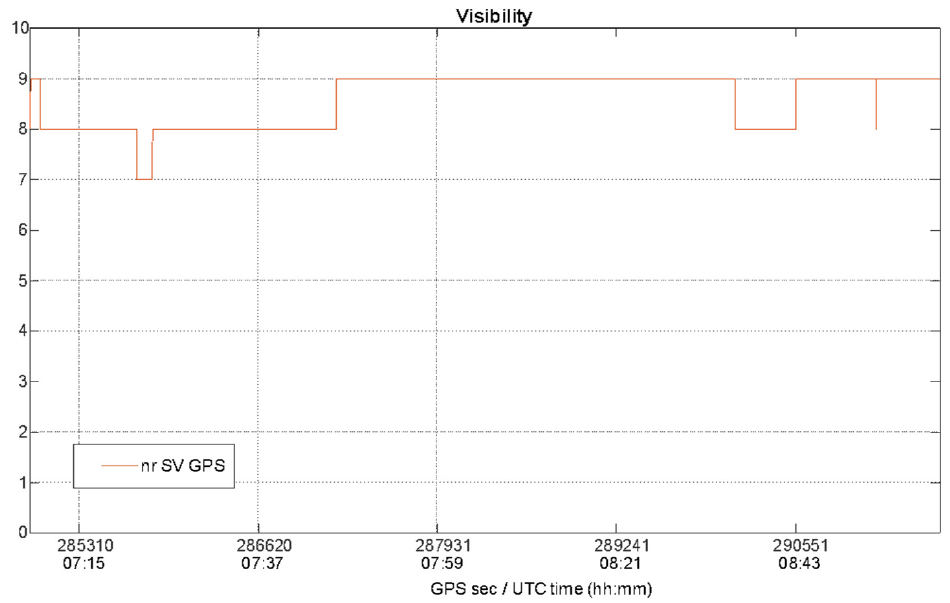
Figure 6. Number of visible GPS satellites during the kinematic test.